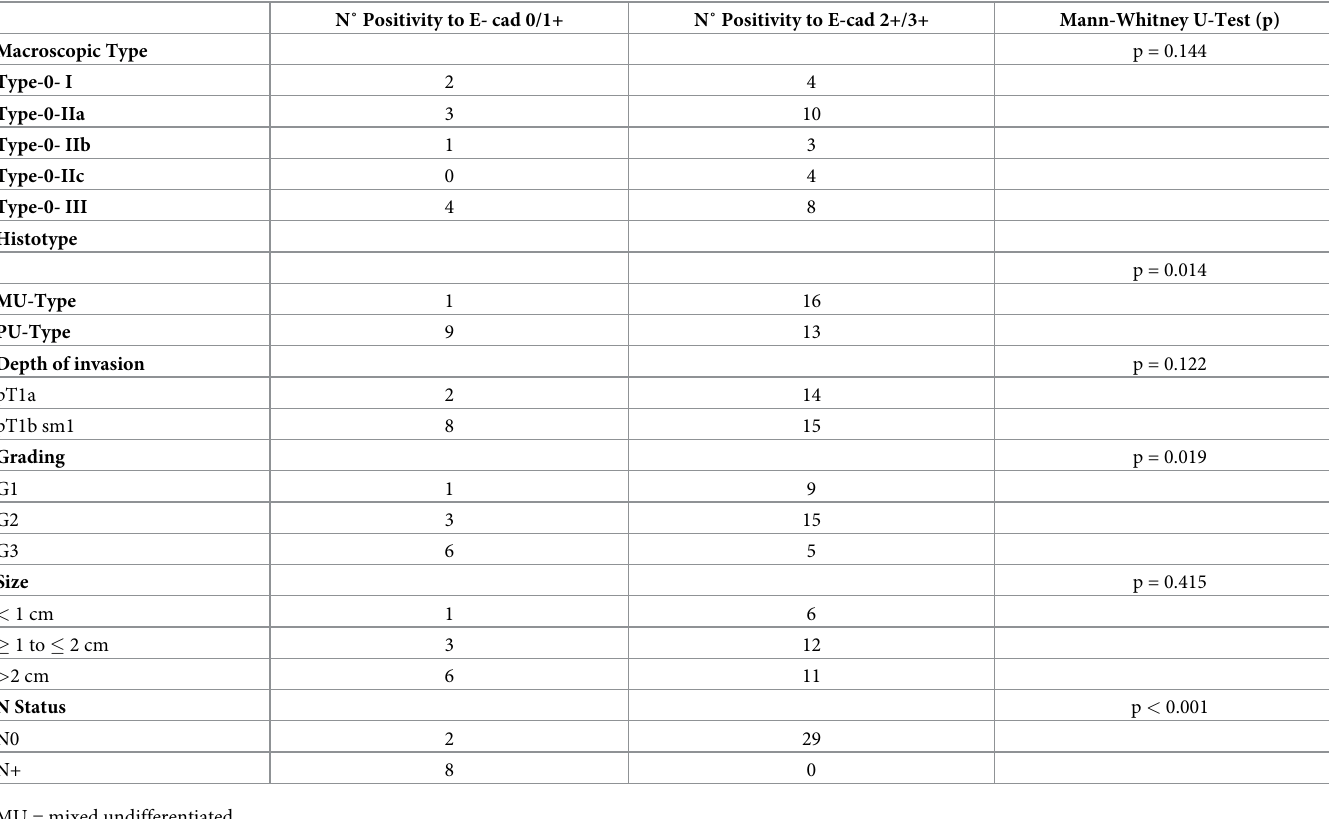
Table 2. Univariate analysis between low E-cadherin expression (E-cad 0 / +1) and high E-cadherin expression (E-cad +2 / +3).